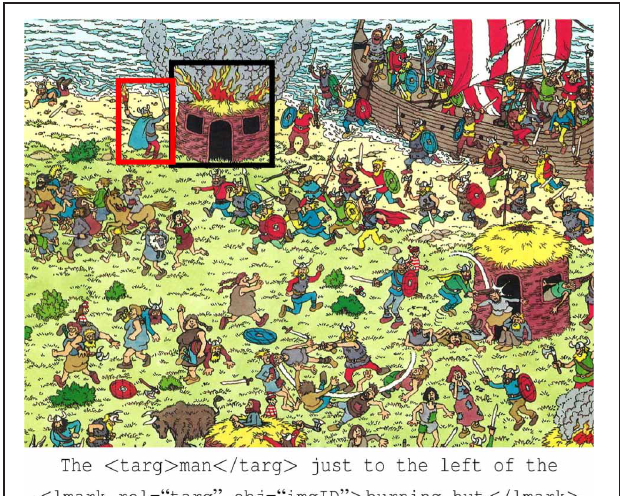
FIGURE 3 | Example easy stimulus (target in red box) and annotated referring expression. Words in < targ > tags describe the target. A single landmark (the burning hut, indicated by the rel attribute) is used to localize the target and was marked with a black box by the annotator.